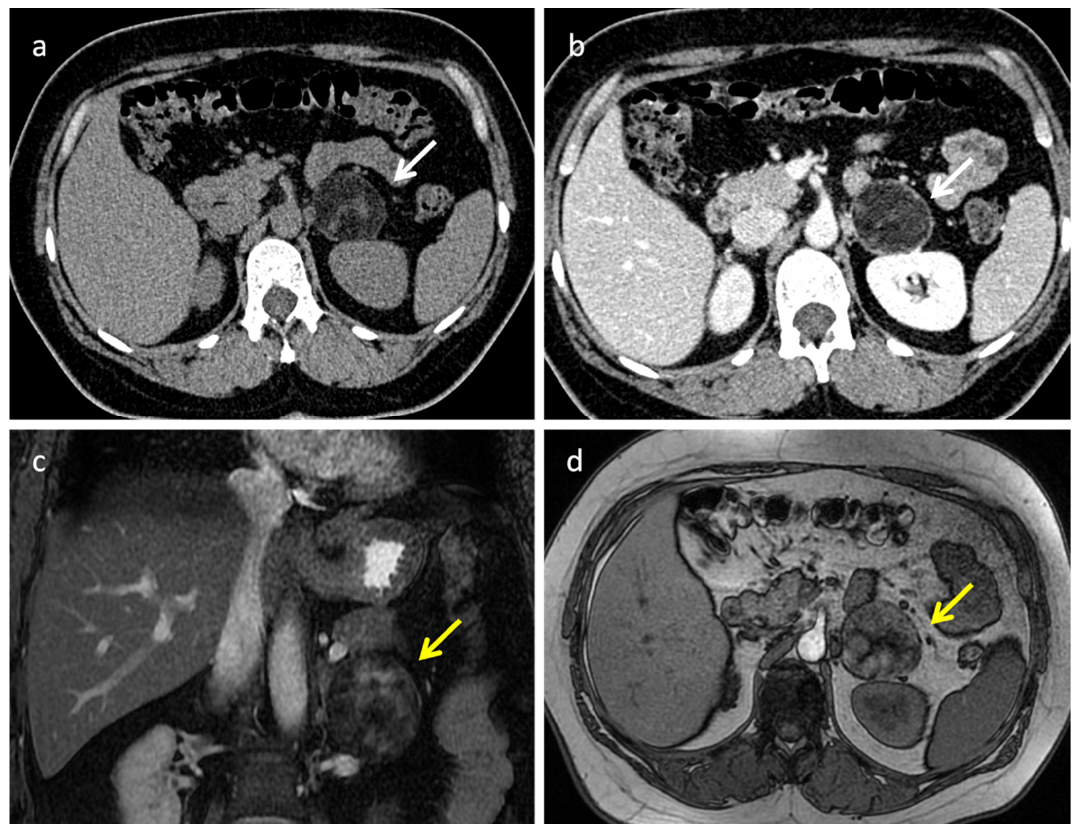
Figure 2. Adrenal myelolipoma in a 42-year-old woman. CT demonstrates a large mass within the left adrenal gland (white arrow in ( a , b ) and yellow arrows in ( c , d )), characterized by well-defined borders and internal inhomogeneity. Axial unenhanced CT ( a ) shows attenuation values < − 30 HU due to the presence of gross fat. On portal venous phase ( b ), the mass shows subtle enhancement due to its poor vascularization. Coronal T2 fat sat sequence ( c ) and axial T1-weighted out-phase image ( d ) demonstrate extracellular fat.